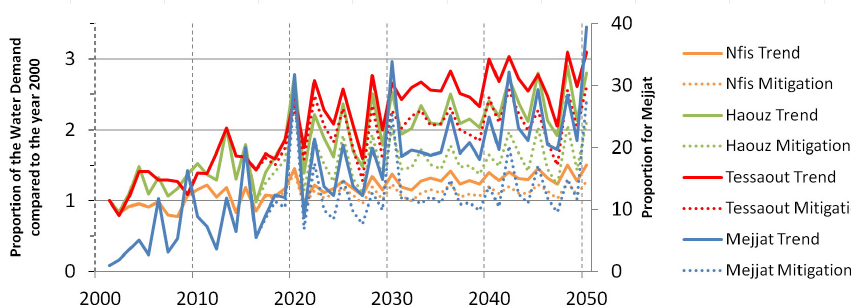
Figure 7. Trend and alternative scenarios for irrigation water demand in the four planning areas of the Tensift with